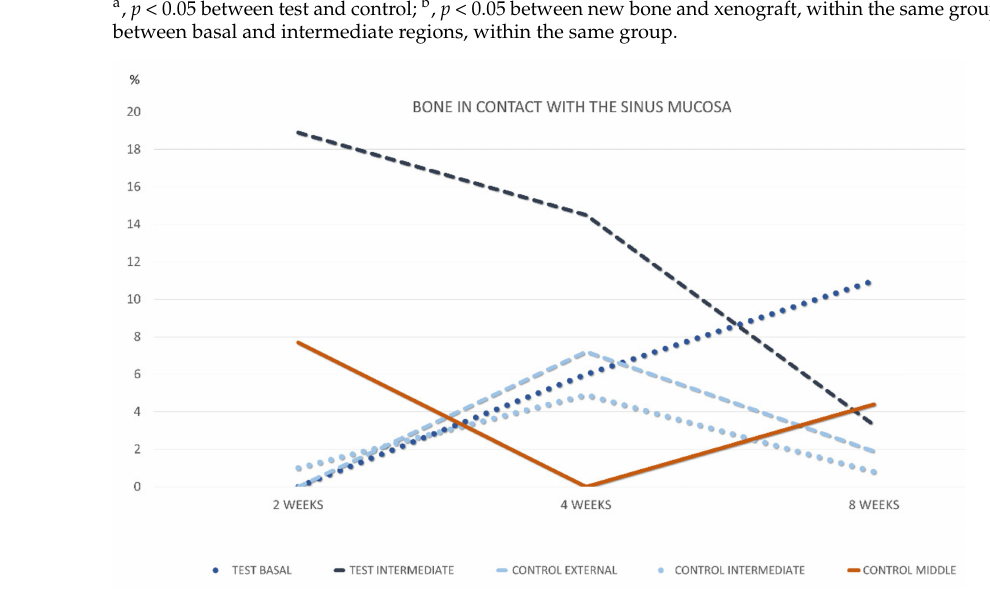
Figure 2. Graph representing the percentage of new bone in contact with the sinus mucosa in the various regions evaluated after 2, 4, and 8 weeks of